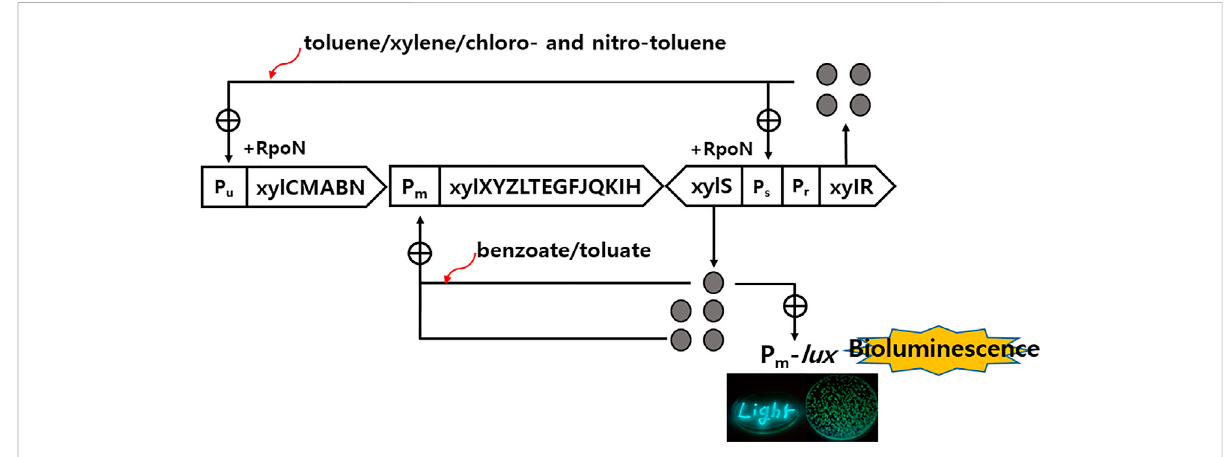
FIGURE 1 Schematic diagram of the regulatory systems of TOL catabolic and recombinant Pm - lux genes ( ⊕ : positive control; C : regulatory protein) (modi fi ed from Kong et al., 2004; Kong 2006; Kong et al.,